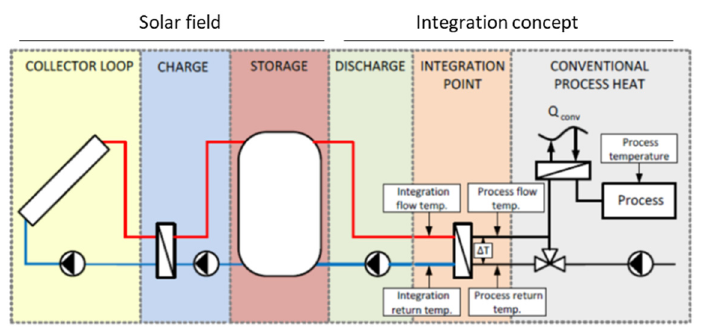
Figure 4. Block diagram of a typical solar thermal integration scheme in an industrial process